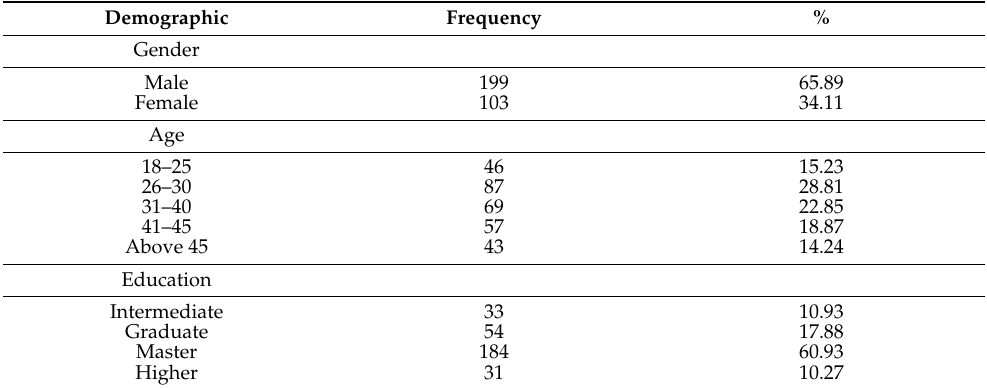
Table 3. Socio-demographic